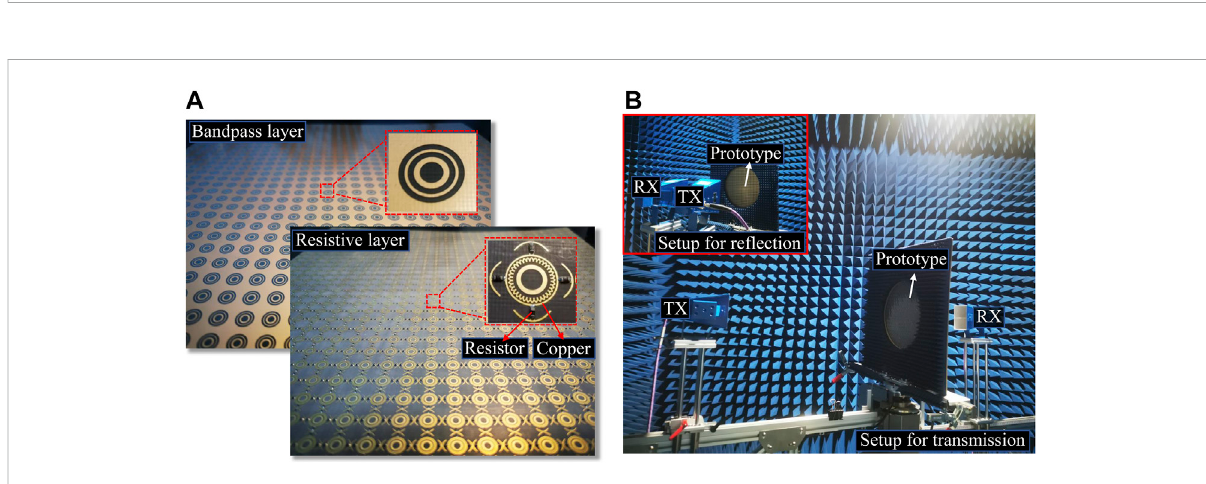
Fabricated prototype and the measurement system (A) Photograph of the prototype. (B) Prototype in the measurement setup with the normal incident